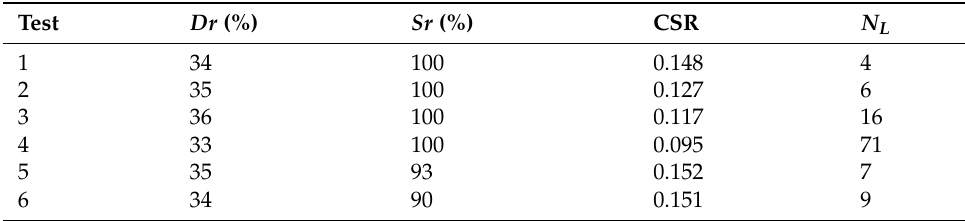
Table 5. Final test conditions and number of cycles to trigger the liquefaction.